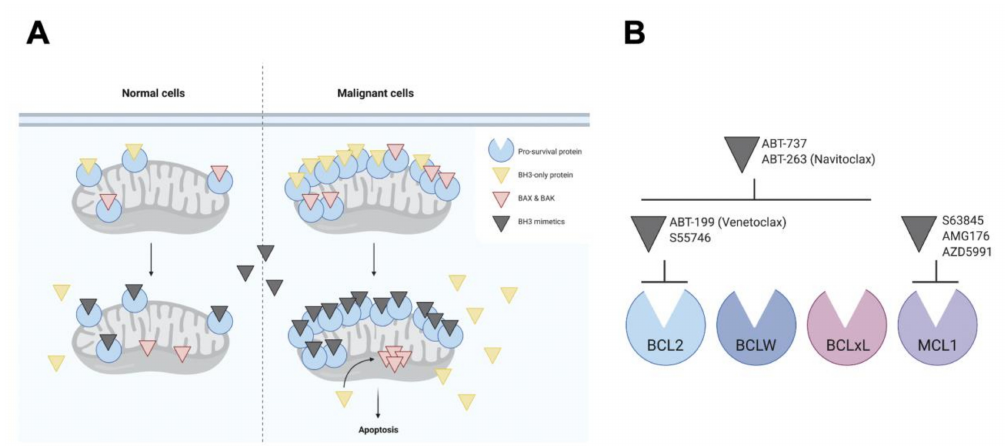
Figure 2. Mechanism of action of BH3 mimetics. ( A ) Pro-survival proteins (e.g., BCL2, B-cell lymphoma extra large [BCLxL], myeloid cell leukemia 1 [MCL1]), shown in blue, are commonly overexpressed in cancer cells, where they sequester high levels of pro-apoptotic proteins, including BH3-only proteins (e.g., BIM), shown in yellow, and pore-forming e ff ector proteins (e.g., BAX, BAK), shown in red, through their BH3 motif to maintain cell survival. These cells are paradoxically “primed” for death, as inhibition of upregulated pro-survival proteins by BH3 mimetics would liberate large quantities of originally sequestered pro-apoptotic proteins, driving the cell toward apoptosis. ( B ) Di ff erent BH3 mimetics target di ff erent pro-survival